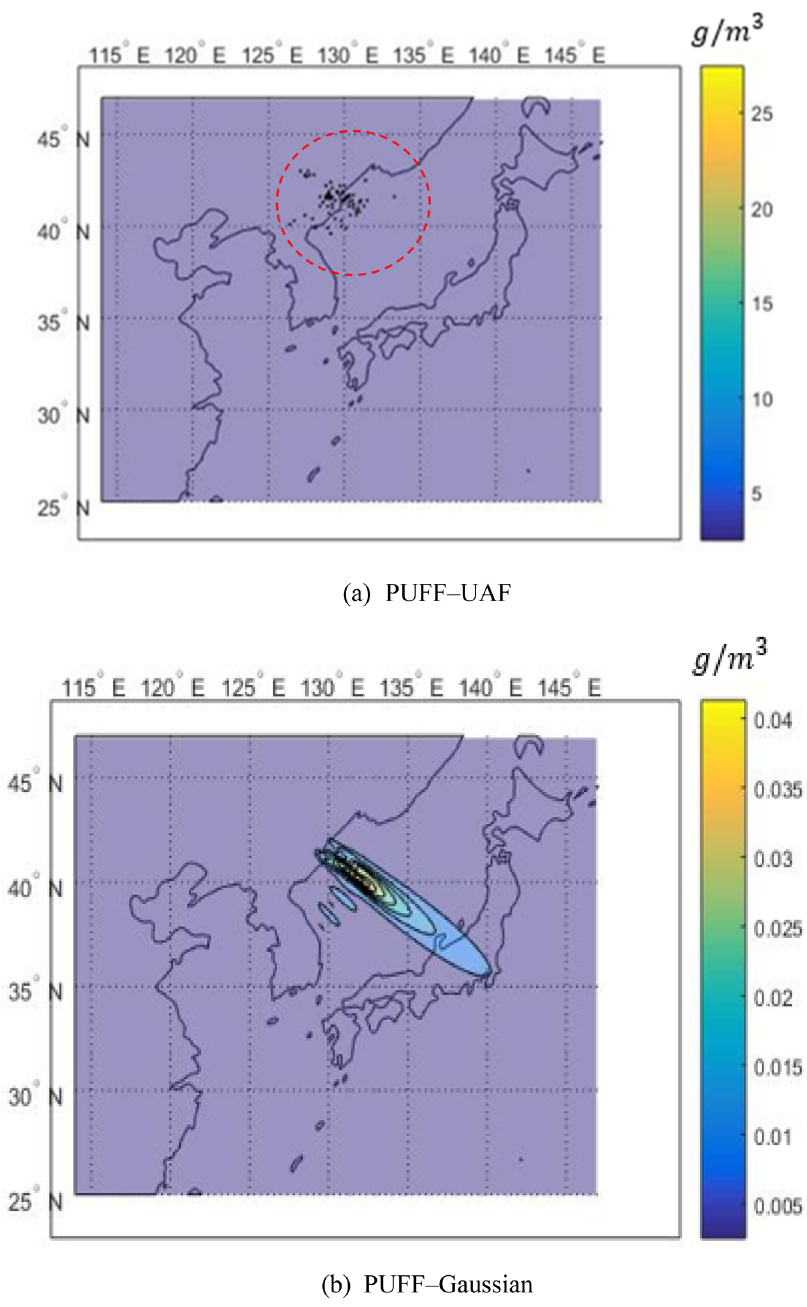
Figure 16. Comparison of ash concentrations at ground level between ( a ) PUFF–UAF and ( b ) PUFF–Gaussian models at 36 h after a hypothetical eruption of Mt. Baekdu on Sep. 7th, 2010 of VEI =